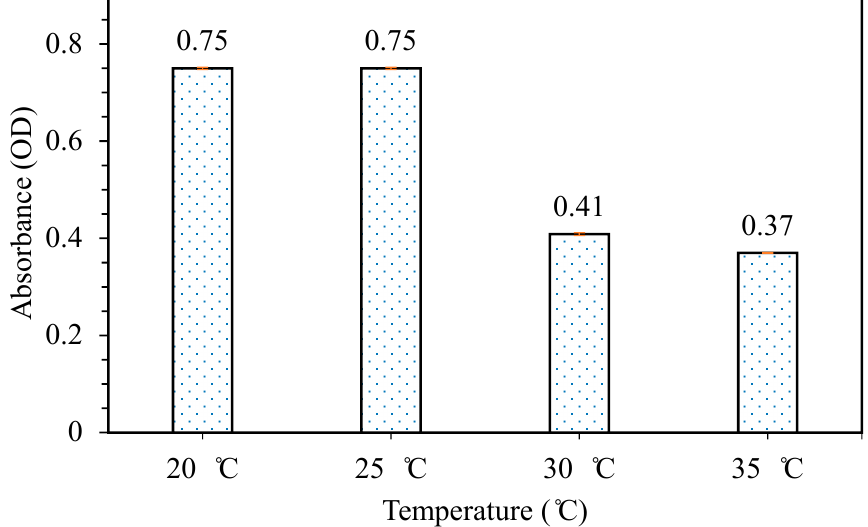
Figure 8. Releasing test of patches prepared at different mixing temperatures.